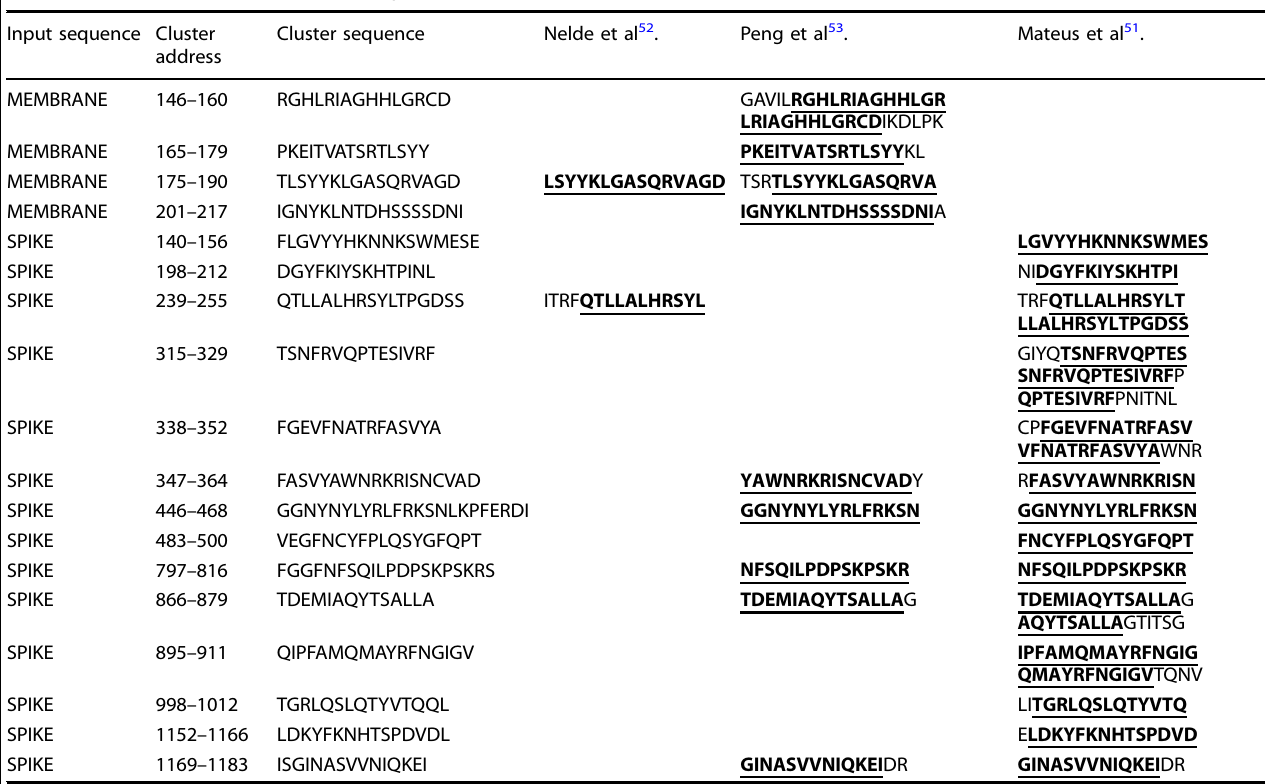
Table 4. Published SARS-CoV-2 surface antigen epitopes a